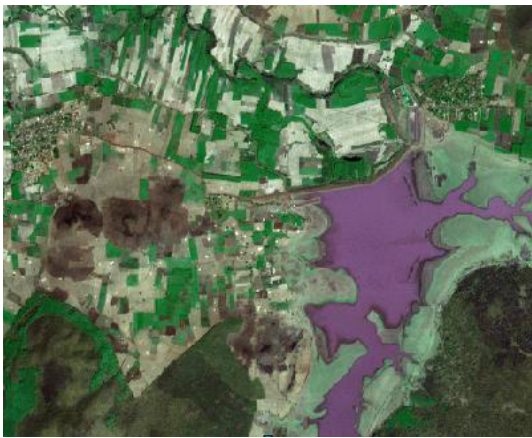
Figure 8: NCC simulated from ERDAS Natural